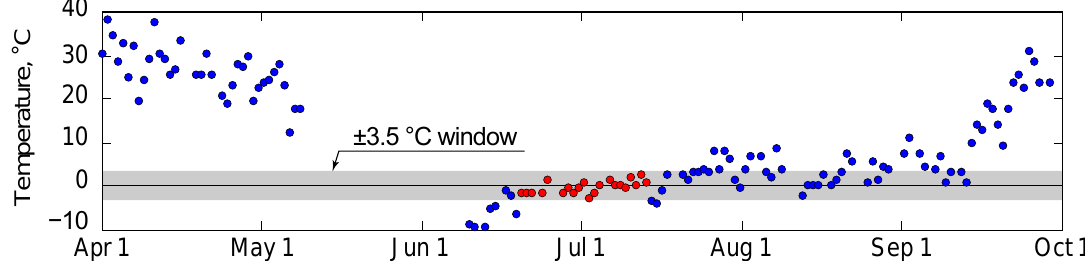
Figure 3. The LST time series for the thawing season, 2017, at Site #2. The zero-curtain (red data points) followed a protracted period of cloudiness during which there were no LST measurements of the ground surface.